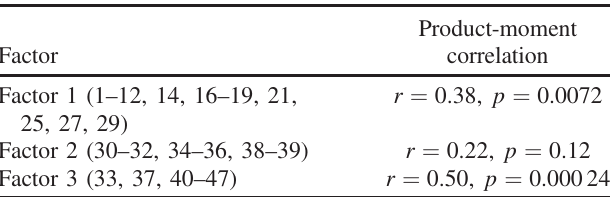
TABLE IV. Product-moment correlations for AP exam score with various factors comprising the FMCE.